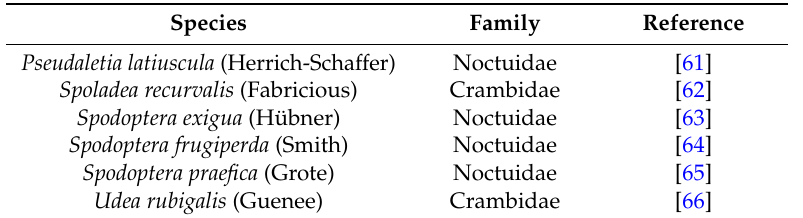
Table 6. List of hosts of C. marginiventris in its native range known prior to its introduction to Hawaii in 1942.